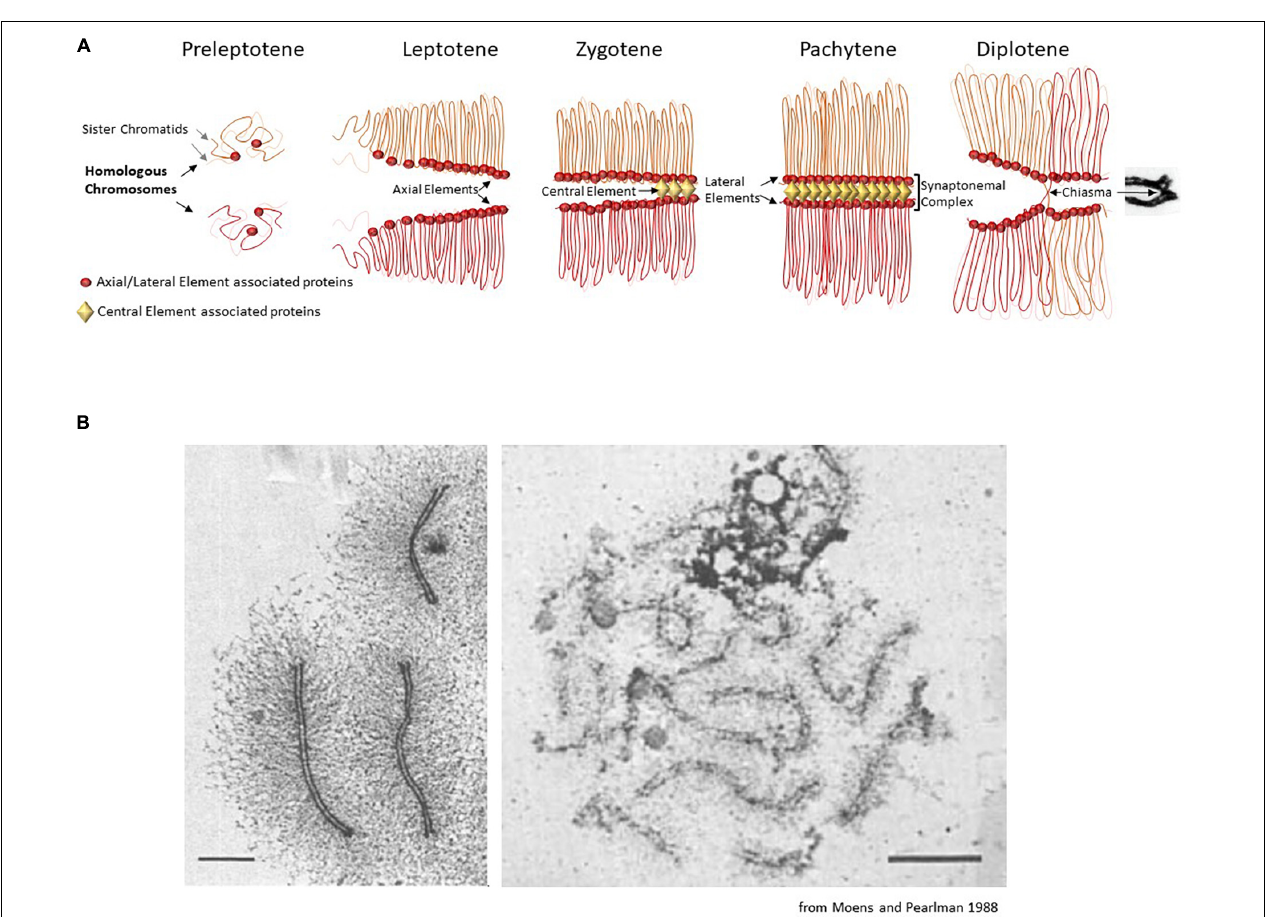
FIGURE 1 | (A) Schematic description of the chromosomal organization during the first meiotic prophase. The first meiosis-specific proteins of the axial element are loaded on chromosomes during meiotic S-phase at the preleptotene stage. At leptotene stage, the elongating axial elements serve as scaffolds along which sister chromatids attach and begin to form an array of loops. At the zygotene stage, the proteins of the central element start to load and to initiate the formation of the synaptonemal complex that associates homologous chromosomes (homologous synapsis). In most organisms, homologous synapsis depends on meiotic DNA double-strand break formation and repair. During the pachytene stage, homologous chromosomes are fully synapsed and the chromatin is organized in a tight loop-axis array. Meiotic double-strand break repair is completed during this stage. The proteins of the central element unload and the synaptonemal complex dissolves during the diplotene stage, while homologous chromosomes remain connected only at centromeres and at chiasmata (the cytological manifestation of crossing-over sites). (B) Chromosome loops and axis visualized by electron microscopy. Left panel: chromosome spread of a pachytene nucleus in the moth Hyalophora columbia . The chromatin loops extend about 3 µ m from the parallel-aligned chromosome cores, which together form the synaptonemal complex. Scale bar = 2 µ m. Right panel: chromosome spread of a pachytene nucleus in S. cerevisiae , presenting a smaller loop size to axis ratio. Scale bar 2 µ